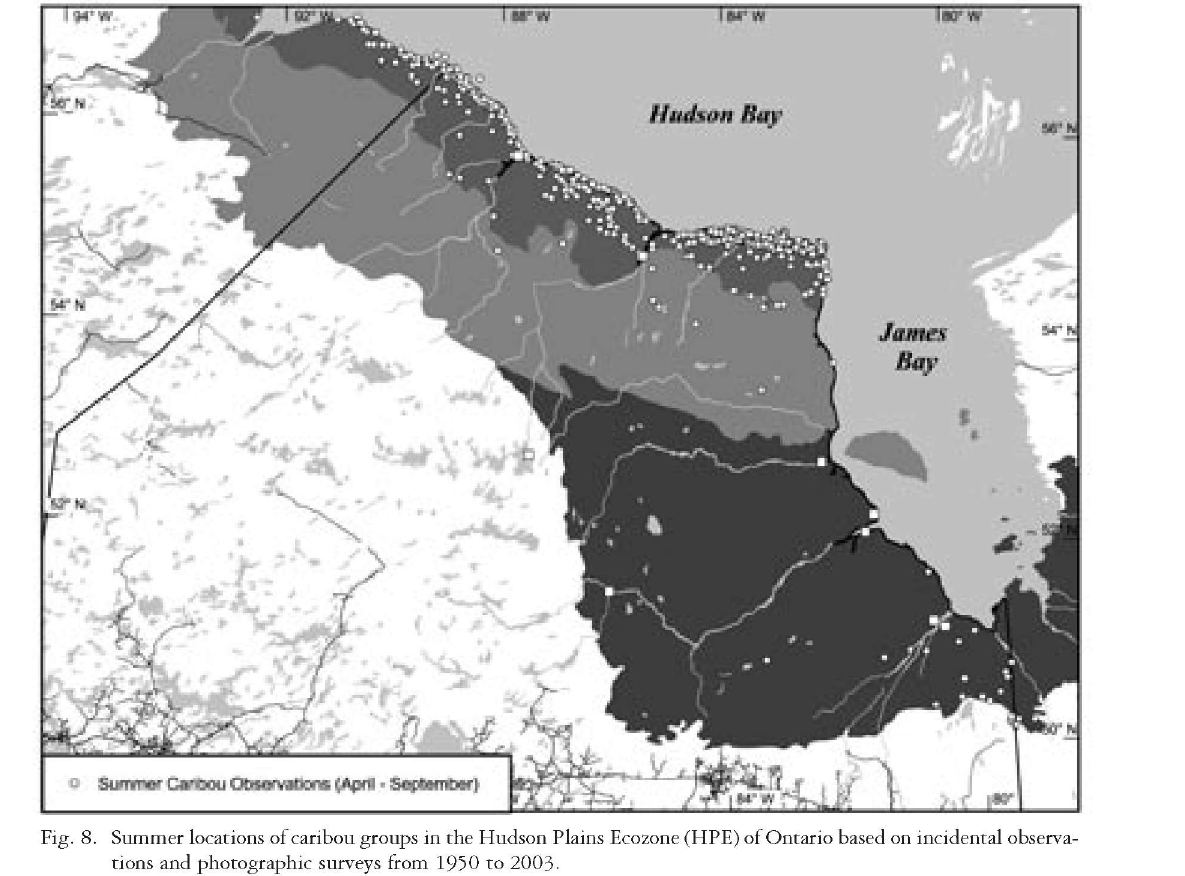
Fig. 8. Summer locations of caribou groups in the Hudson Plains Ecozone (HPE) of Ontario based on incidental observa tions and photographic surveys from 1950 to